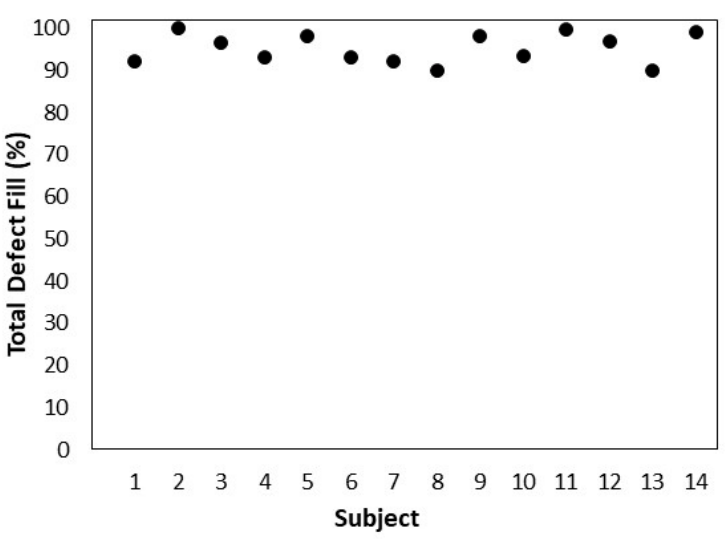
Figure 1. Total Defect Fill (%) by quantitative MRI for individual subjects at a mean followup of 7.9 years after ChondroMimetic treatment. Total Defect Fill (%) was determined using 3D quantitative magnetic resonance imaging by calculating the ratio of the new repair tissue (bone and cartilage) volume at followup, to original defect (bone and cartilage) volume acquired from 10 days post-operative scans (baseline). (n =